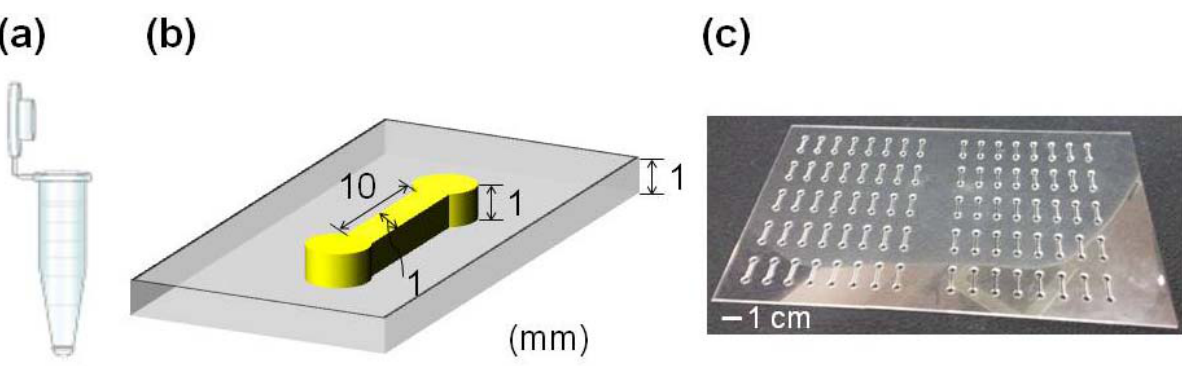
Figure 1. Bacterial culture systems used in this study. ( a ) Schematic view of PS microtubes and ( b ) microfluidic channels. ( c ) A microfluidic channel